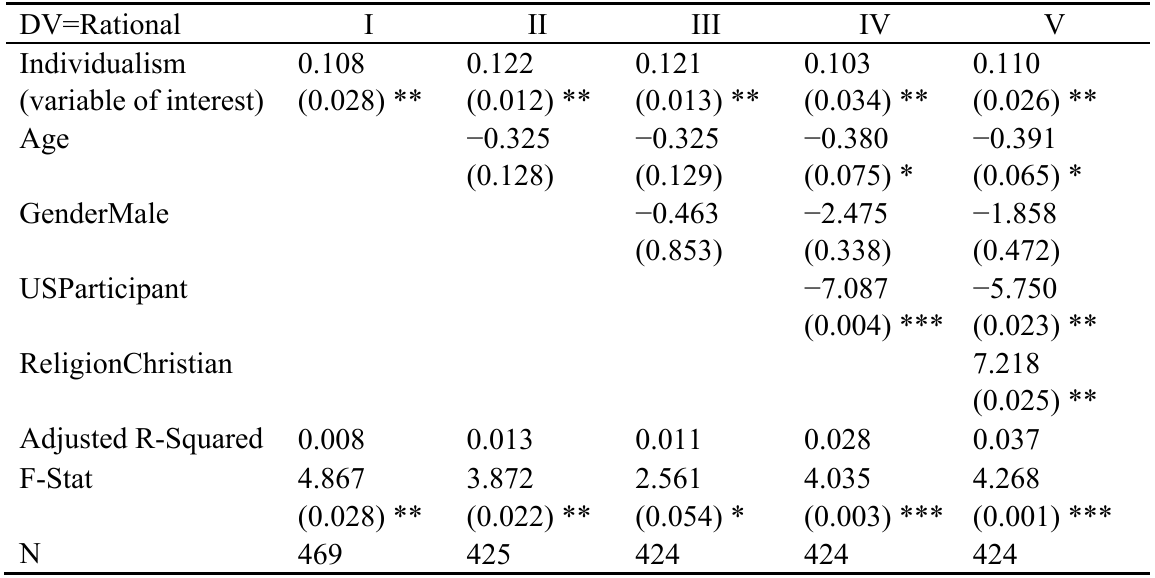
Table 1. OLS Regression Results for Rational Decision-Making Style.